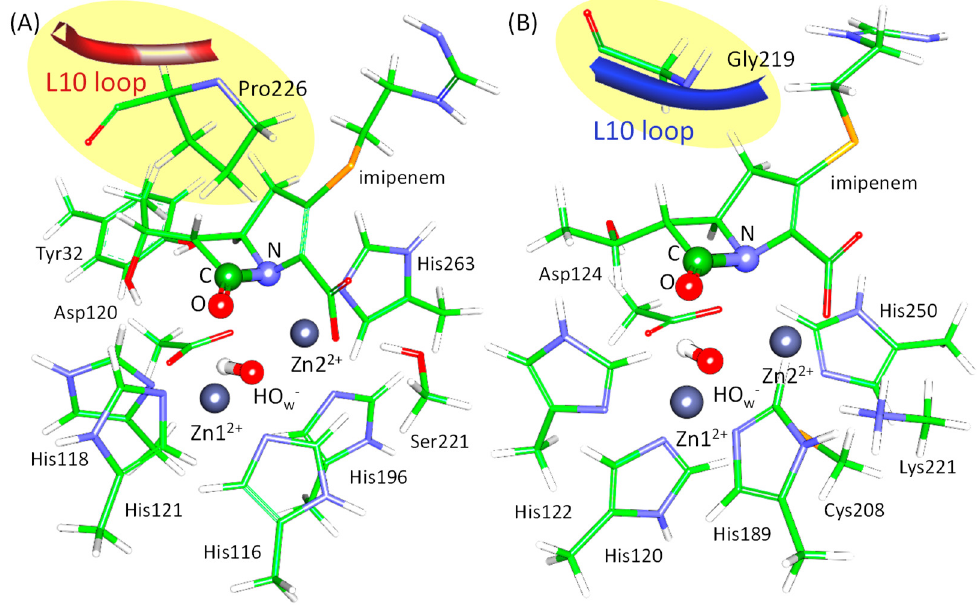
Figure 1. Active sites of the L1 ( A ) and the NDM-1 ( B ) with imipenem. The fragment of the L10 loop is shown in red for the L1 and in dark blue for the NDM-1. Coordination spheres of zinc cations and side chains of amino acid residues forming hydrogen bonds with the carboxyl group of imipenem are depicted with thin sticks. The N–C=O fragment of the β -lactam ring that participates in chemical reaction is shown in thick sticks. Here, carbon is green, oxygen is red, nitrogen is blue, hydrogen is white, sulfur is yellow, and zinc is dark gray.